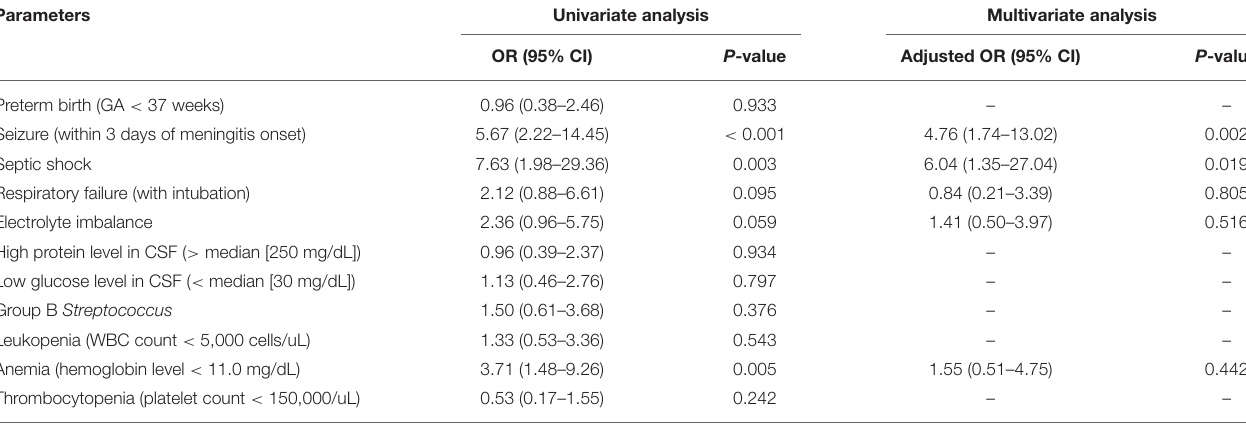
TABLE 3 | Risk factors for final unfavorable outcomes (death or major neurological sequelae at discharge) by univariate and multivariate